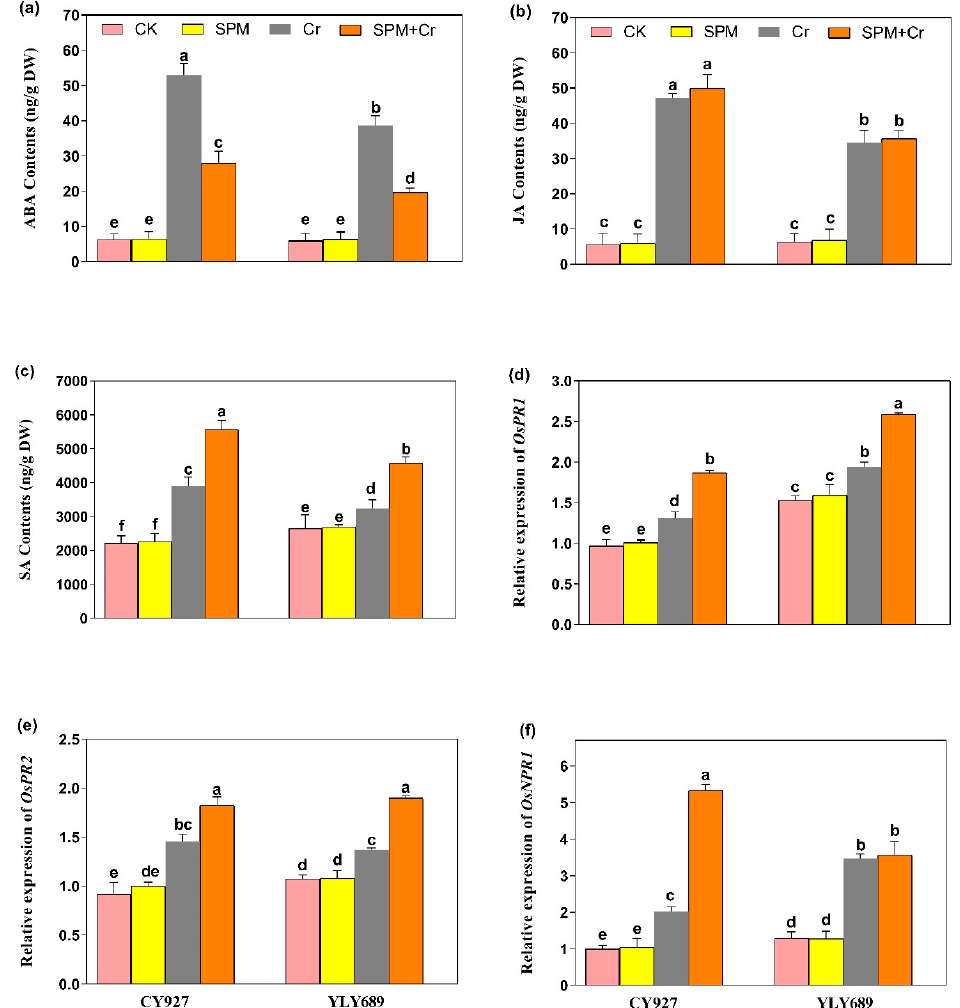
Figure 5. Effects of SPM on the endogenous production of phytohormones including ( a ) abscisic acid (ABA), ( b ) Jasmonic acid (JA), ( c ) salicylic acid (SA) and expressions of phytohormones-associated genes ( d ) PR1 , ( e ) PR2 , and ( f ) NPR1 in two rice cultivars (CY927 and YLY689) under chromium (Cr) stress. Values are mean ± SE of three independent replicates and different letters (a–f) above bars show a significant difference between treatments by LSD test at p < 0.05